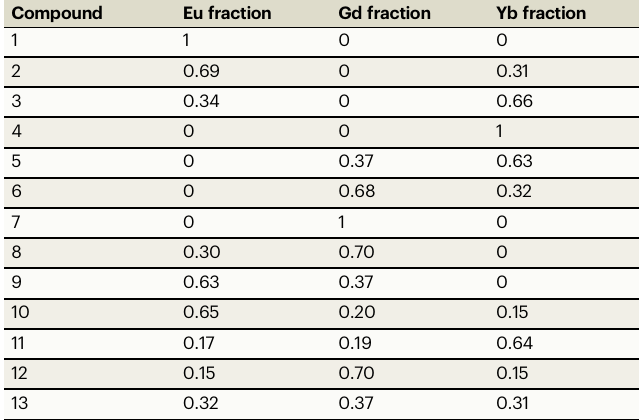
Table 1 | Compound ID numbers and their fractional metallic compositions